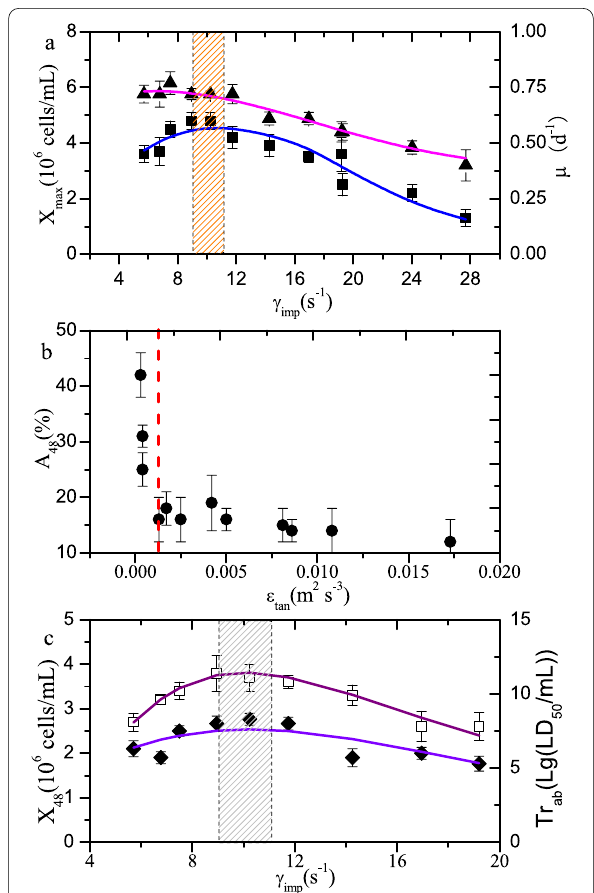
Fig. 5 Effects of shear environment in the 5-L bioreactor on BHK-21 cell growth performance and virus titer. Effect of shear rate in the impeller zone ( γ imp ) on the highest viable cell density ( X max , filled square) and average specific growth rate of BHK-21 cells during the first 24 h post-inoculation ( μ 24 , filled triangle) ; effect of ε tan on the ratio of aggregated cells at 48 h ( A 48 , filled circle); and effect of γ imp on the viable cell density at 48 h ( X 48 , Square) and rabies virus titer ( T rab , filled diamond)